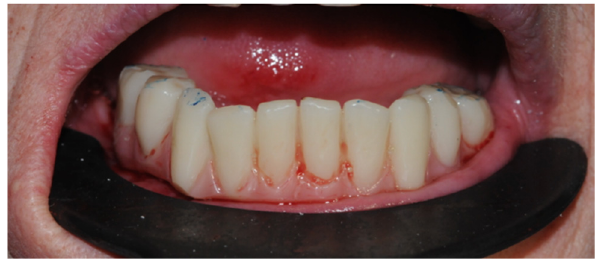
Figure 16. Provisional prosthesis after surgery.